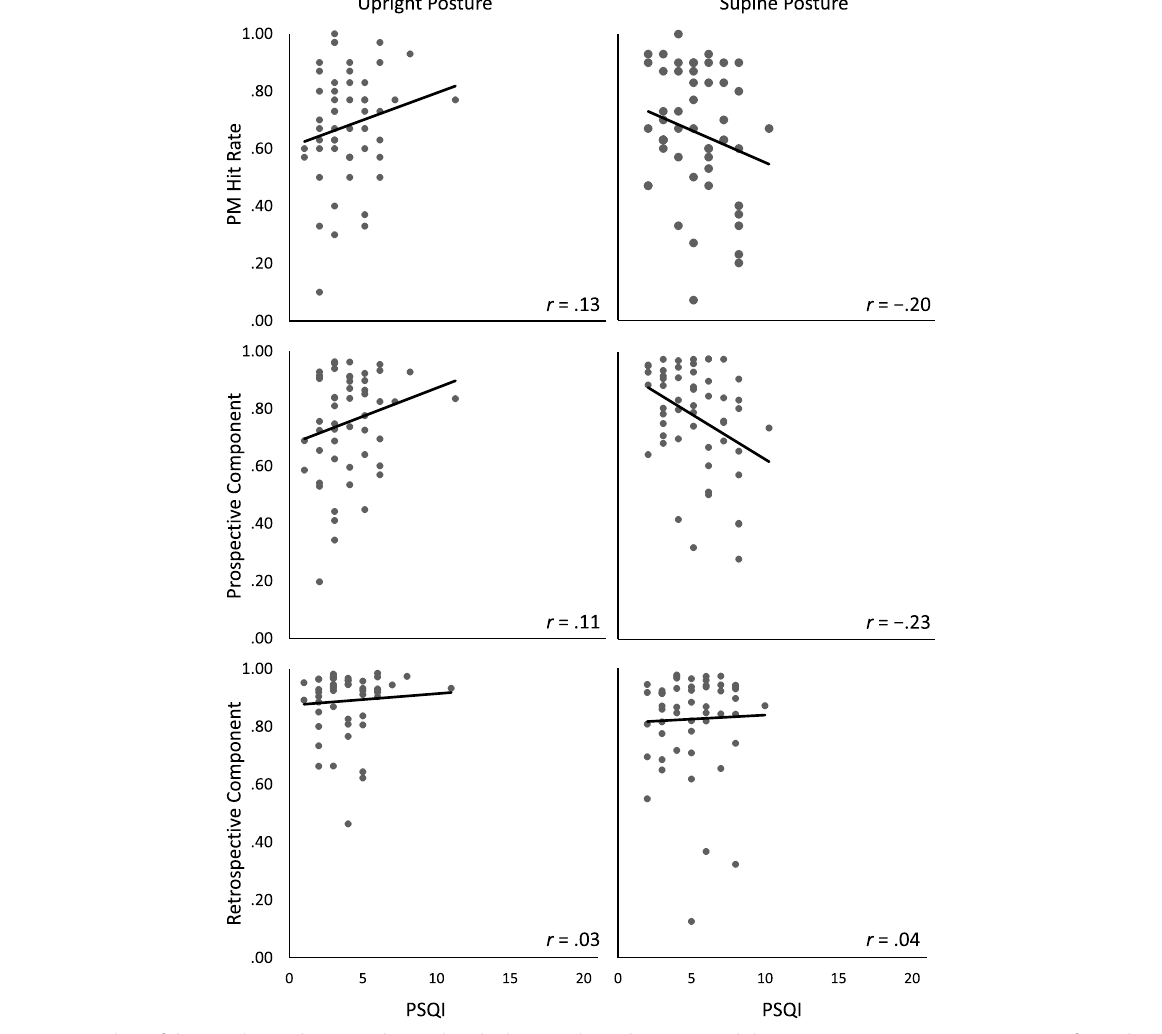
Fig. 4 Scatterplots of the correlations between the Pittsburgh Sleep Quality Index (PSQI) and the prospective-memory (PM) measures for each posture group. Note that higher scores on the PSQI indicate poorer subjective sleep